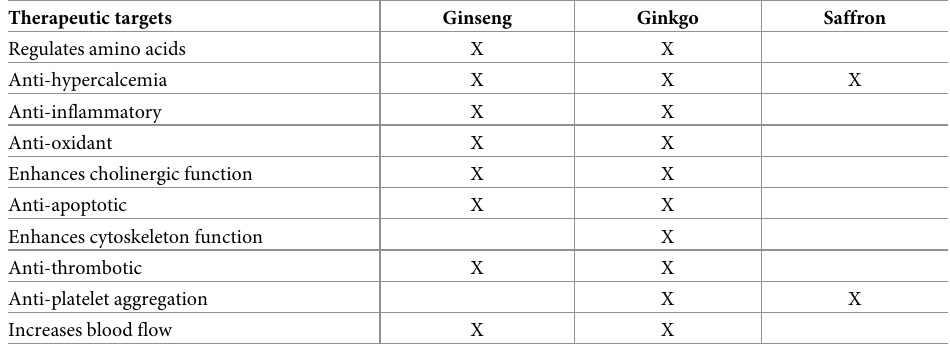
Table 1. The multi-targeting effects of SLT components on VaD